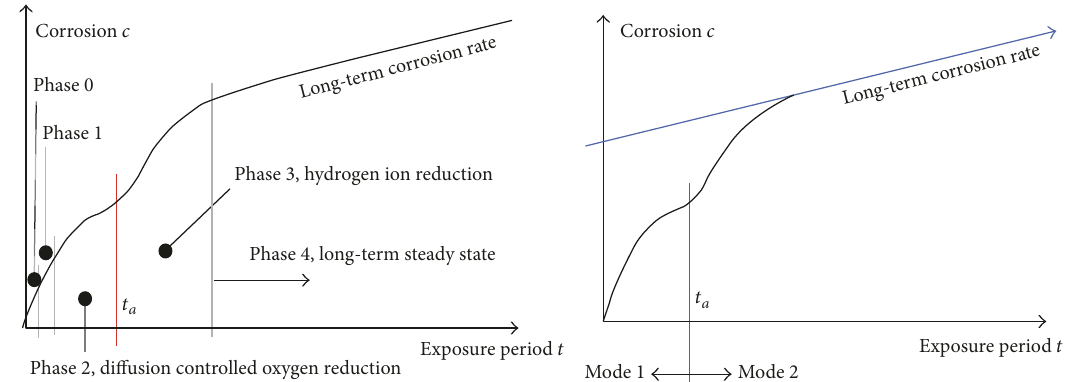
Figure 7: Schematic bimodal model for long-term corrosion loss and pit depth in marine environments. The change from mode 1 with predominantly oxic corrosion conditions to mode 2 with predominantly anoxic conditions occurs at 𝑡 𝑎